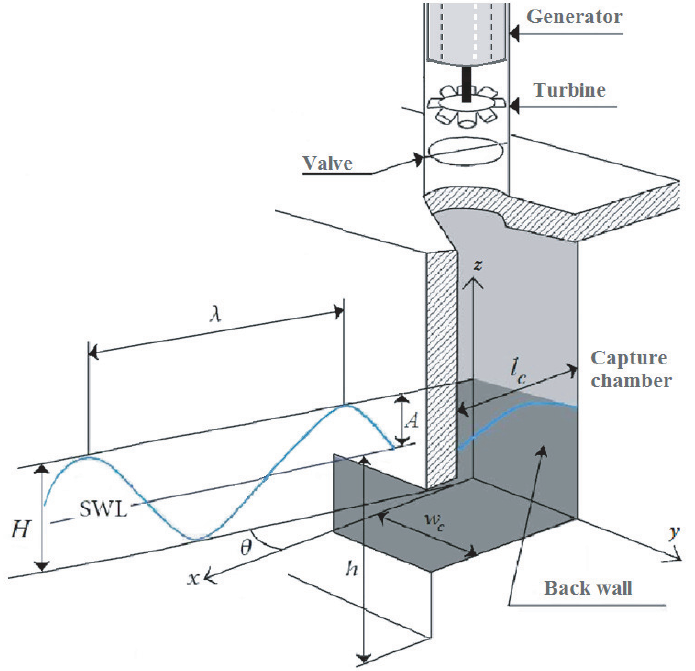
Figure 1. Scheme of an Oscillating-Water-Column system and the sea